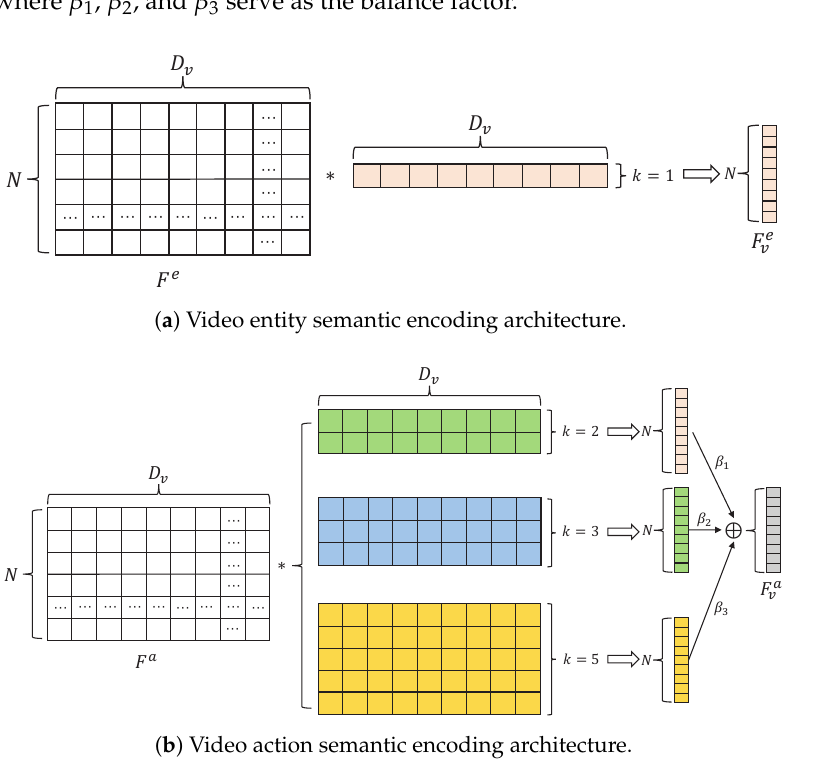
Figure 6. The structures of video entity and action semantic encoding using different 1D CNN. (5) Video relationship semantic